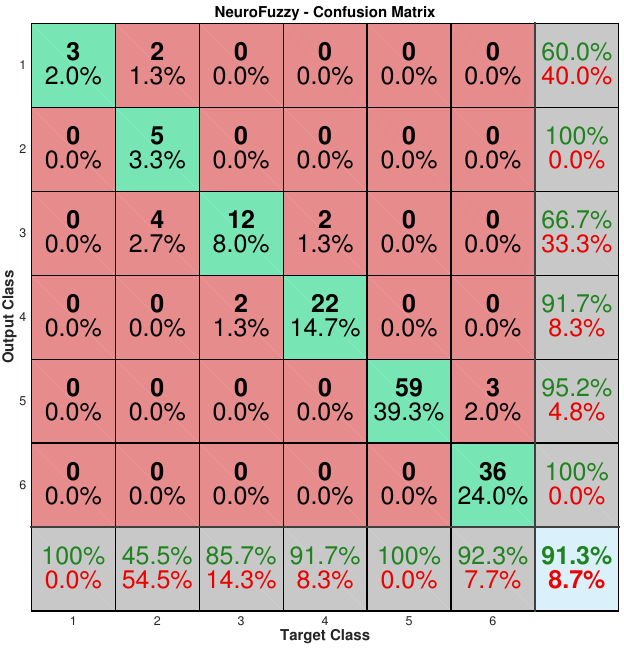
Figure 10. Confusion Matrix of the Neuro-Fuzzy System Approach.